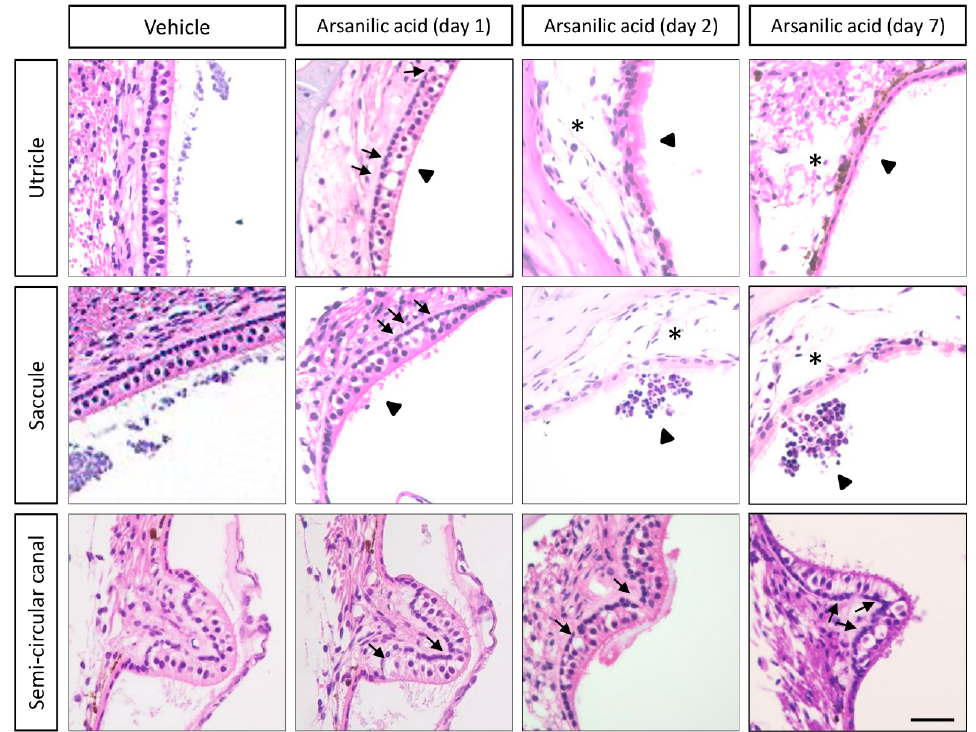
Figure 2. Histological observations (hematoxylin–eosin staining) after unilateral labyrinthectomy with arsanilic acid or phosphate buffer (vehicle) in mice. The vehicle group shows negligible damage in the utricles, saccules, and semi-circular canals. In the arsanilic acid group, vacuoles can be seen in the utricles and saccules at 1 day after surgery (arrows). The vacuoles gradually increase in size, and the macular structures are destroyed by 2 days after surgery (asterisk). The vacuoles are also observed in the semi-circular canals at 1, 2, and 7 days after surgery (arrows). In the utricles and saccules, the disarrangement and loss of otoconia could be observed (arrowheads). Scale bar, 20 µm.